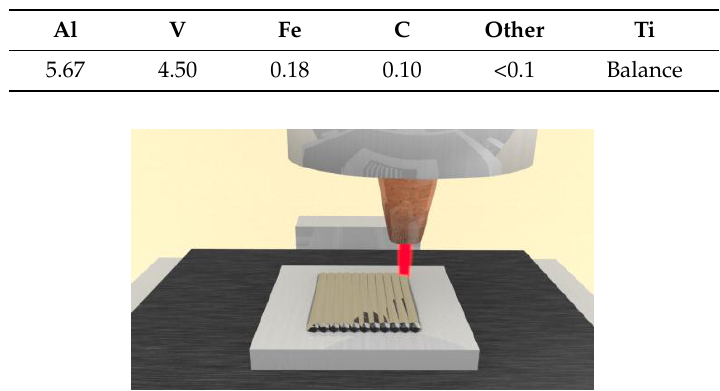
Table 1. Chemical composition of titanium alloy (% mass).